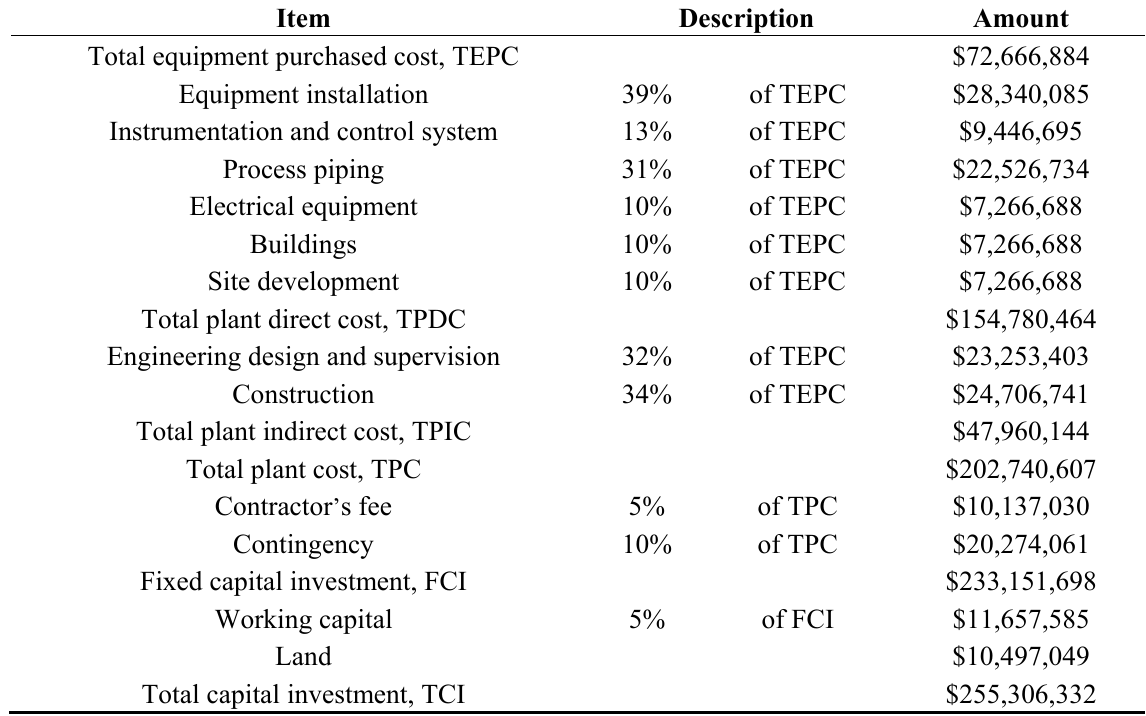
Table 9. Summary of the total capital investment (Scenario